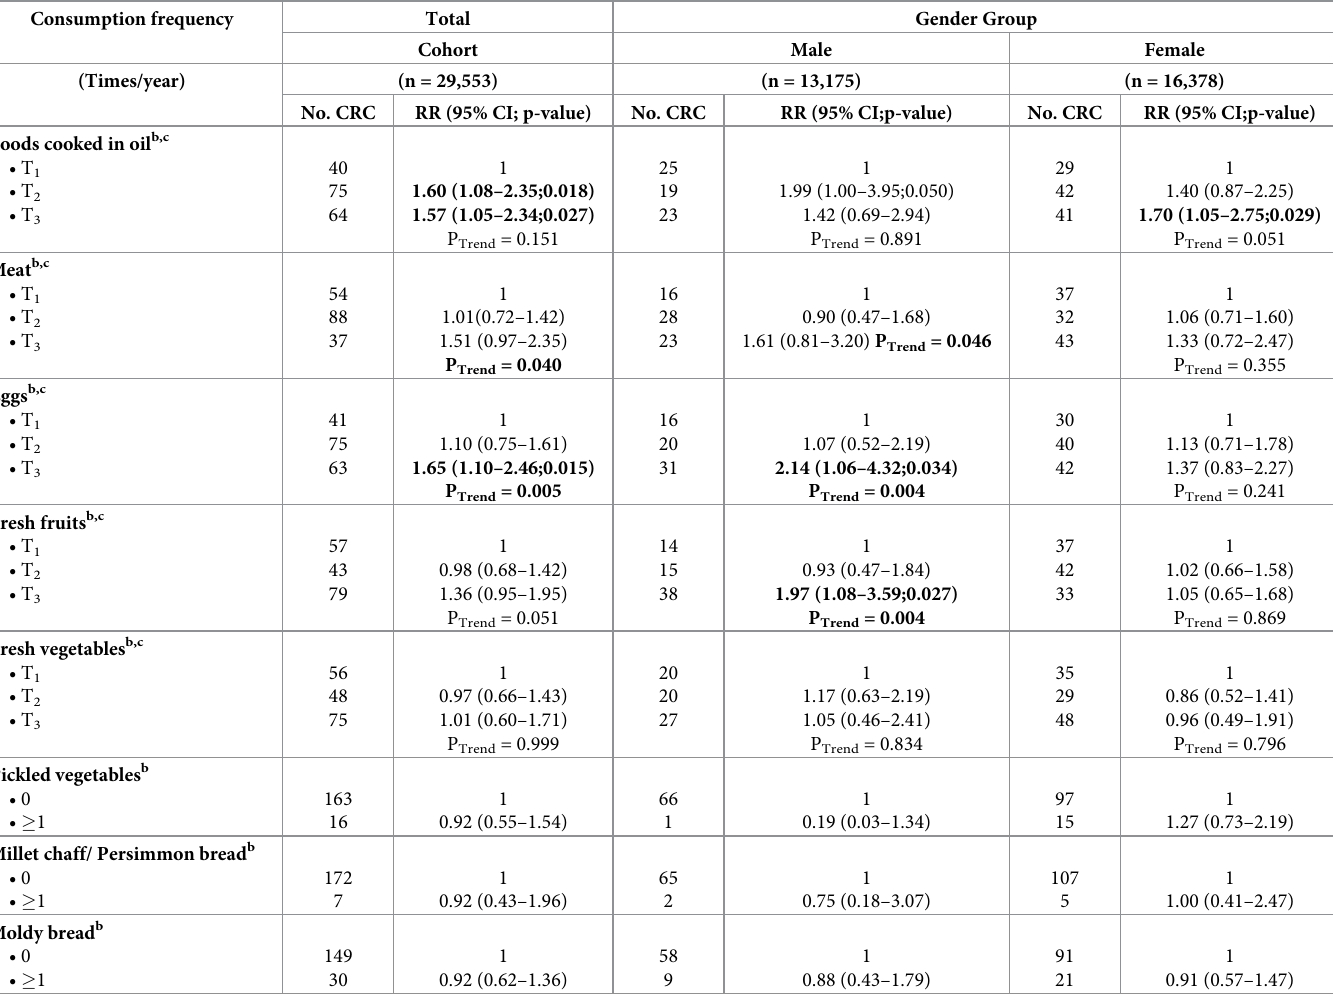
Table 3. Multivariate-adjusted RRs and 95%CIs for colorectal cancer by consumption of selected foods in the total cohort and by gender a . Consumption